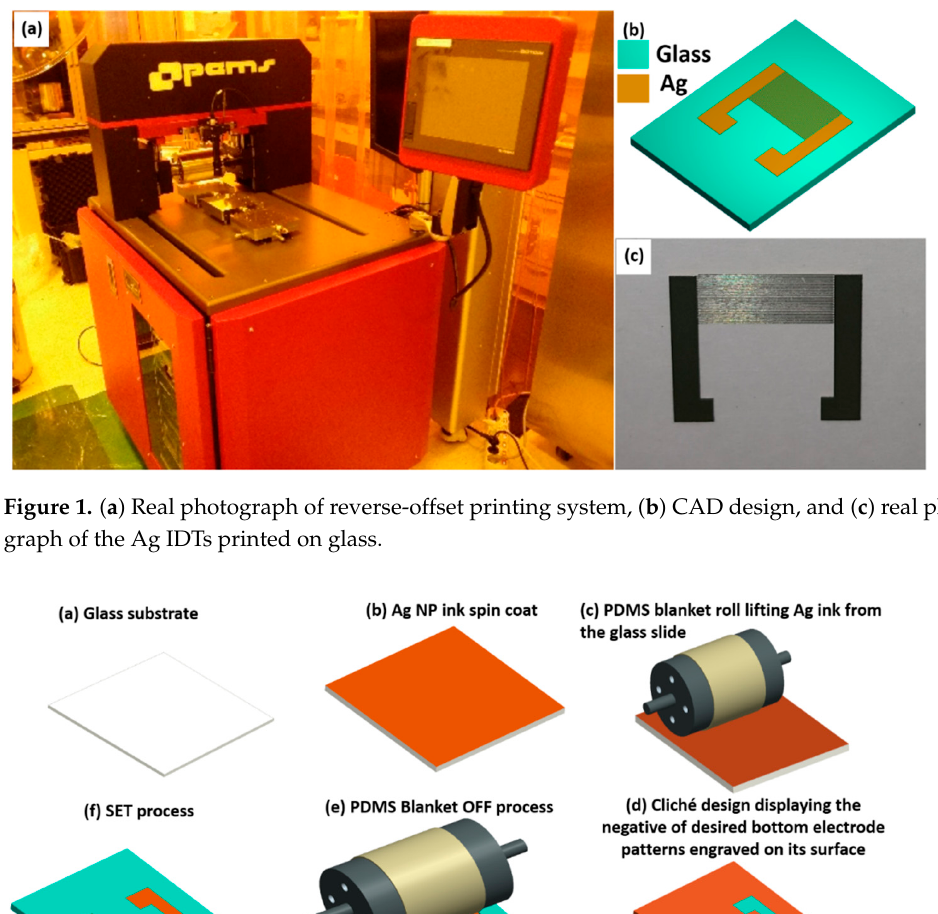
Figure 1. ( a ) Real photograph of reverse-offset printing system, ( b ) CAD design, and ( c ) real photo- graph of the Ag IDTs printed on glass.